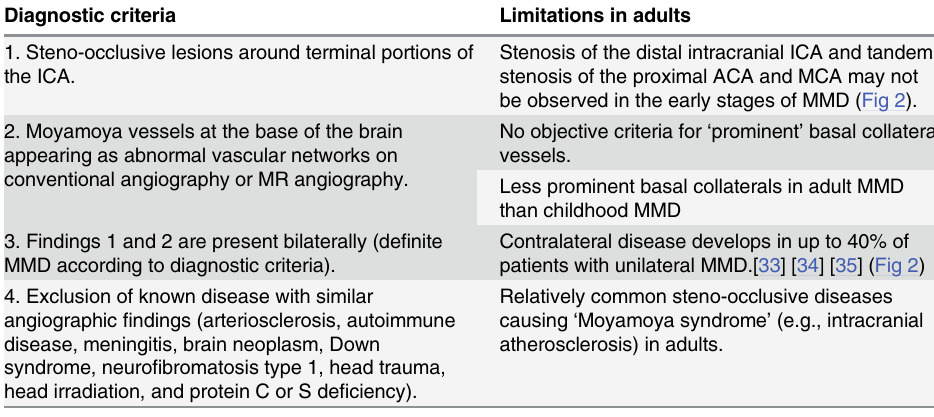
Table 1. Diagnostic criteria and their limitations in adult